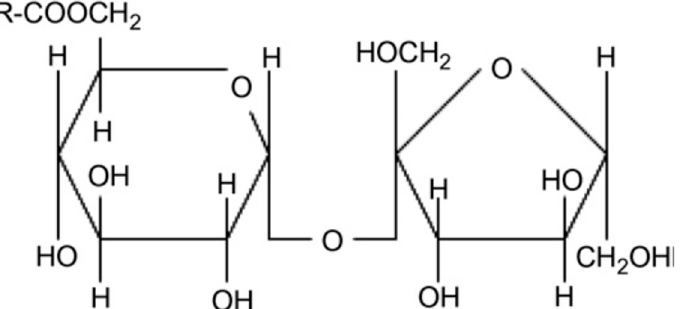
Figure 1. Chemical structure of sucrose monoester, where R = alkyl group. For sucrose stearate, R = stearic acid.